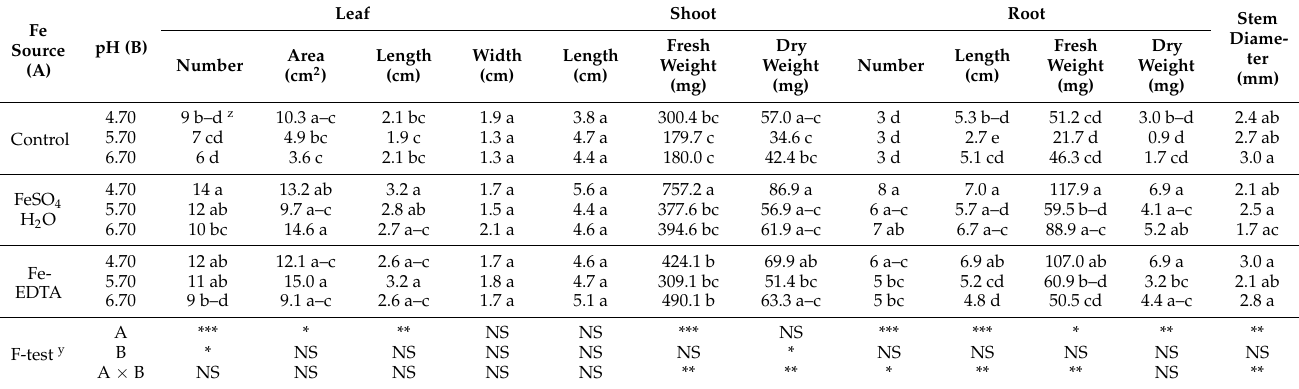
Figure 2. Photographs showing the morphology of H. macrophylla as affected by the Fe source and medium pH after 60 days of culture: ( A ) a top view of the plantlets, still in the medium; and ( B ) representative individual plantlets. The bars in each photograph indicate 1 cm. Table 3. The growth parameters of H. macrophylla after 60 days of culture.